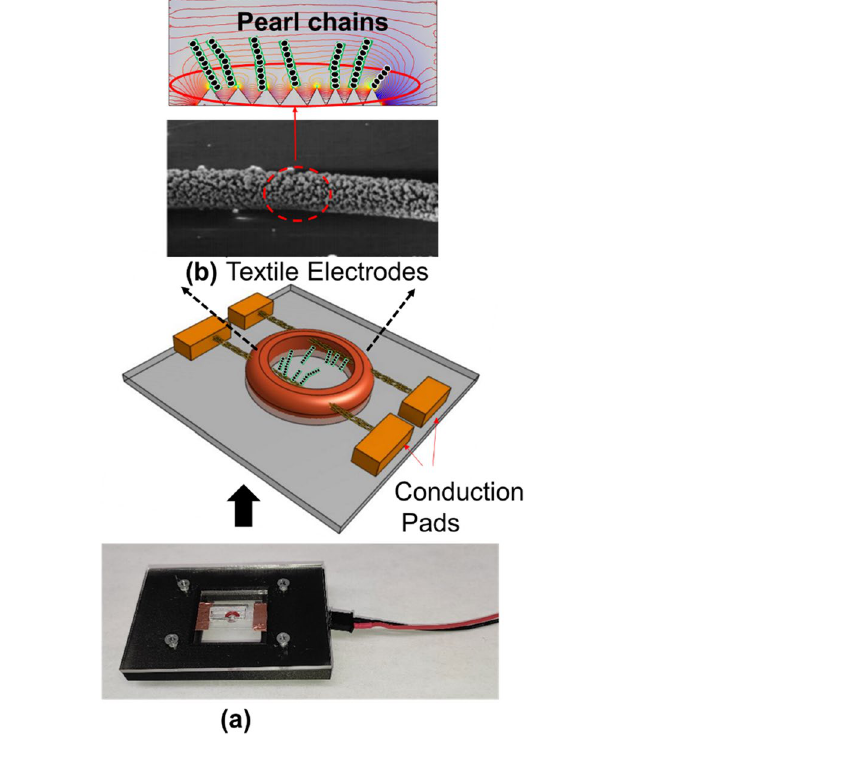
Figure 1. ( a ) Textile electrode-based DEP device with the connection base ( b ) SEM micrograph of textile